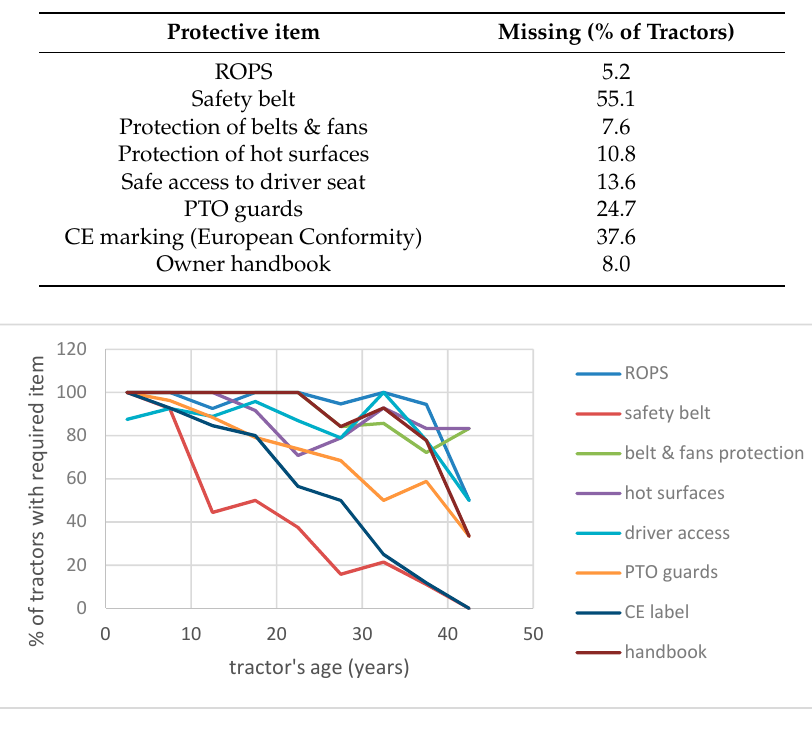
Figure 4. Extract from the software designed for the analysis of the tractors ( a ), ( b ) specific ROPS (rollover protection system) control areas. 3.2. Second-Level Analysis of the Sample Based on 11 Farms The second survey investigated three groups of farms: vineyard farms, cattle and cereal farms, and a third group of mixed farms (Table 7). This involved an overall number of 58 agricultural tractors.